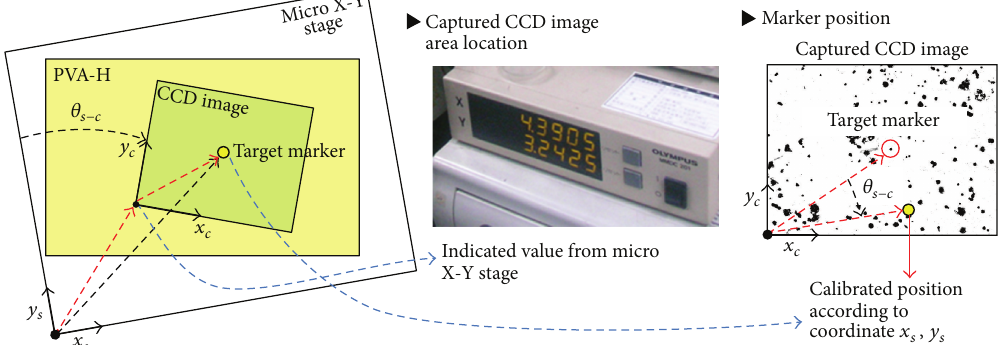
Figure 2: Global coordinates of a target position on the PVA-H surface.